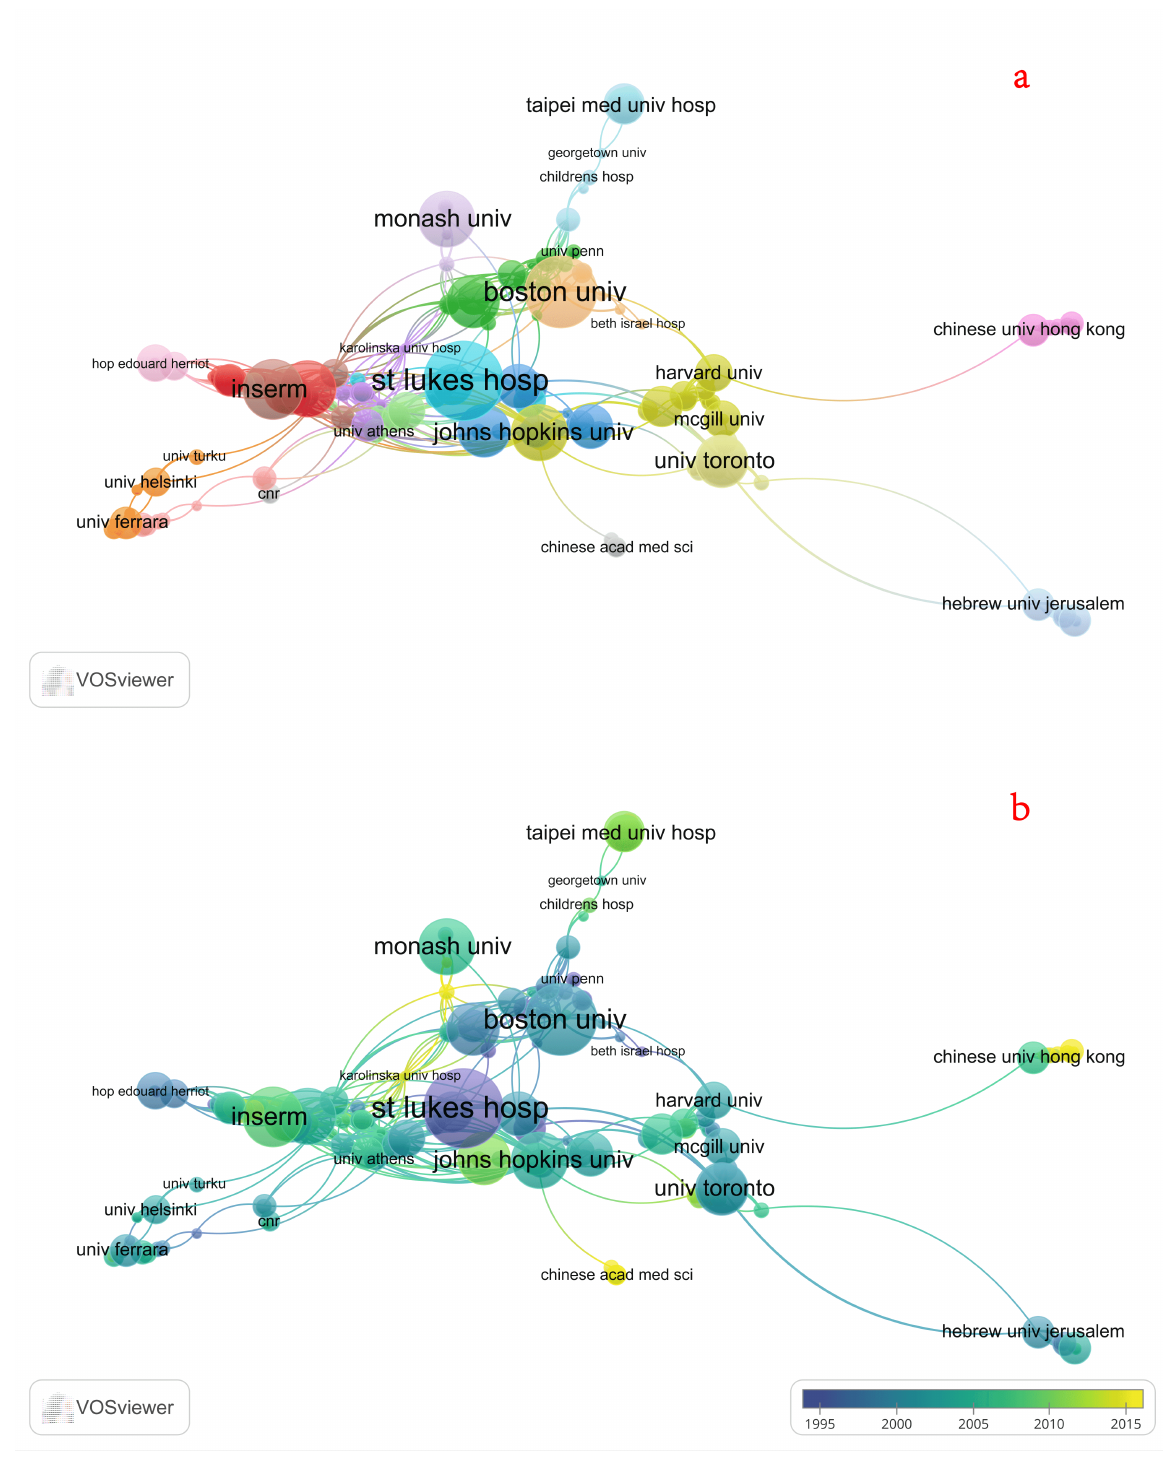
Fig. 5. The font size of each institution’s name represents the number of articles in the institutions. The thickness of the curved connecting line represents the collaborative intensity between institutions. (a) Institution collaboration network of AVD research. (b) Different colors inside the circle represent different time